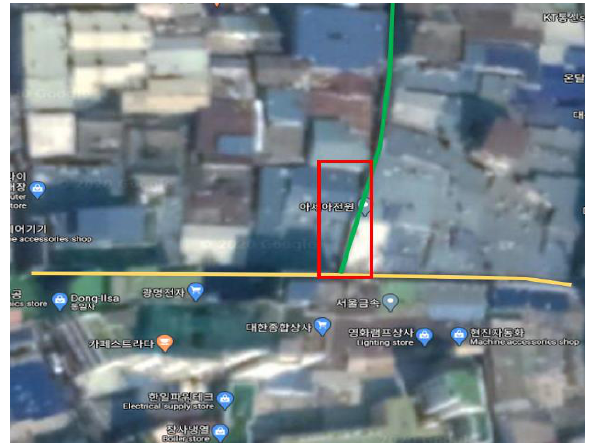
Figure 7. the green line and red line are Jong-ro 24 gil and Donhwamoon-ro 2 gil respectively. The red box is the target façade of building. The Sewoon market is on the right side of the